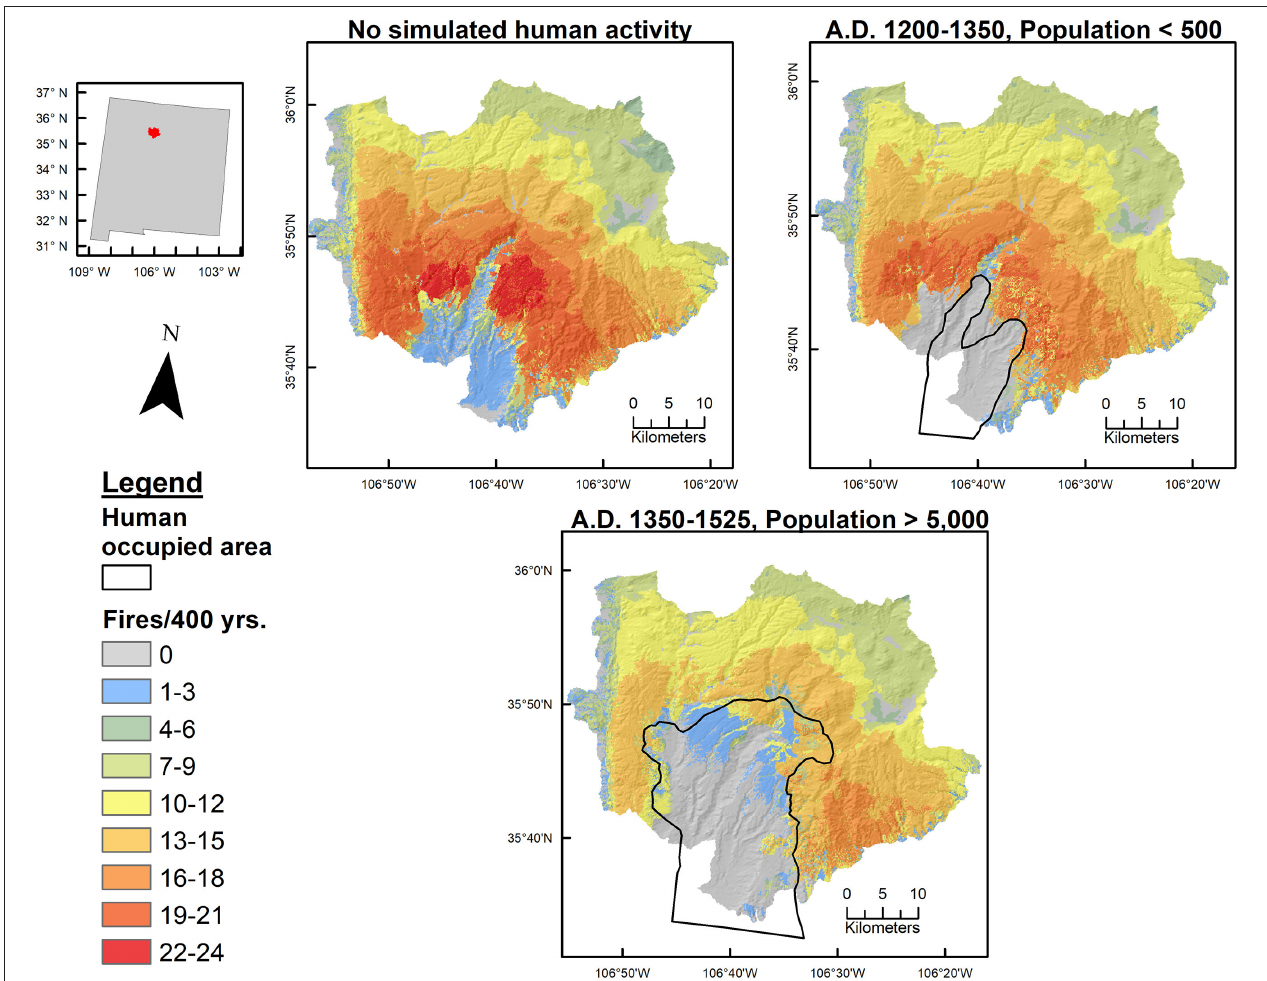
FIGURE 4 | Fire occurrence (cumulative fires/400 years) simulated for two historical time periods in the Jemez Mountains, New Mexico, U.S. As compared with a scenario in which prehistoric human activities were not included, modeled surface and canopy fuelwood gathering and tree harvest reduced fire occurrence proportional to population size ( < 500 people or > 5,000 people) and extent of activity area (indicated by black polygons). Changes to fire regimes occurred because of human-influenced changes in the amount, type, and arrangement of fuels, against a backdrop of climate variability. Adapted from Loehman (2016).